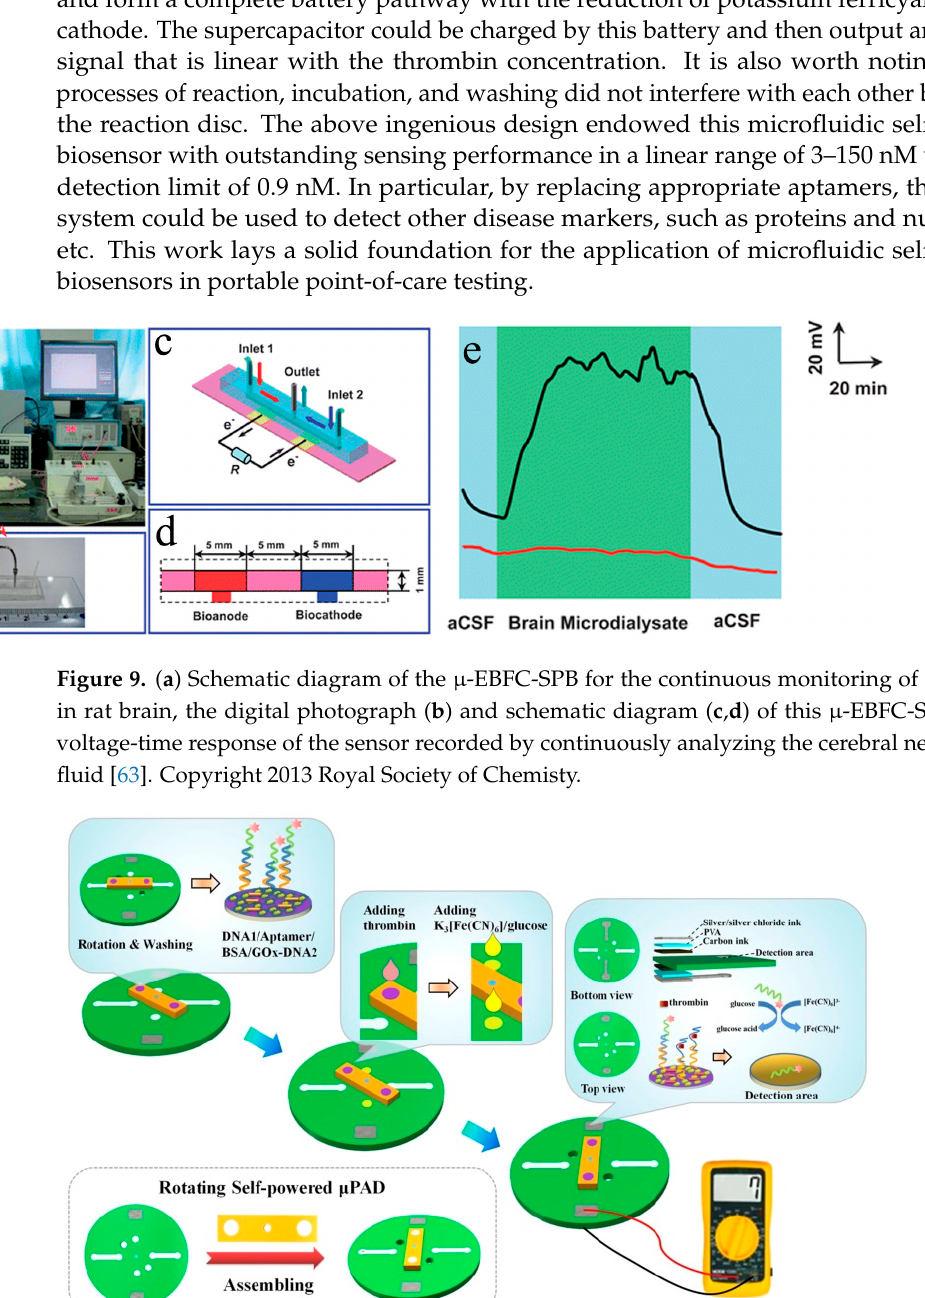
Figure 10. Schematic diagram of the rotational μ -EBFC-SPB and its working principle for throm- bin detection [64]. Copyright 2022 Elsevier.